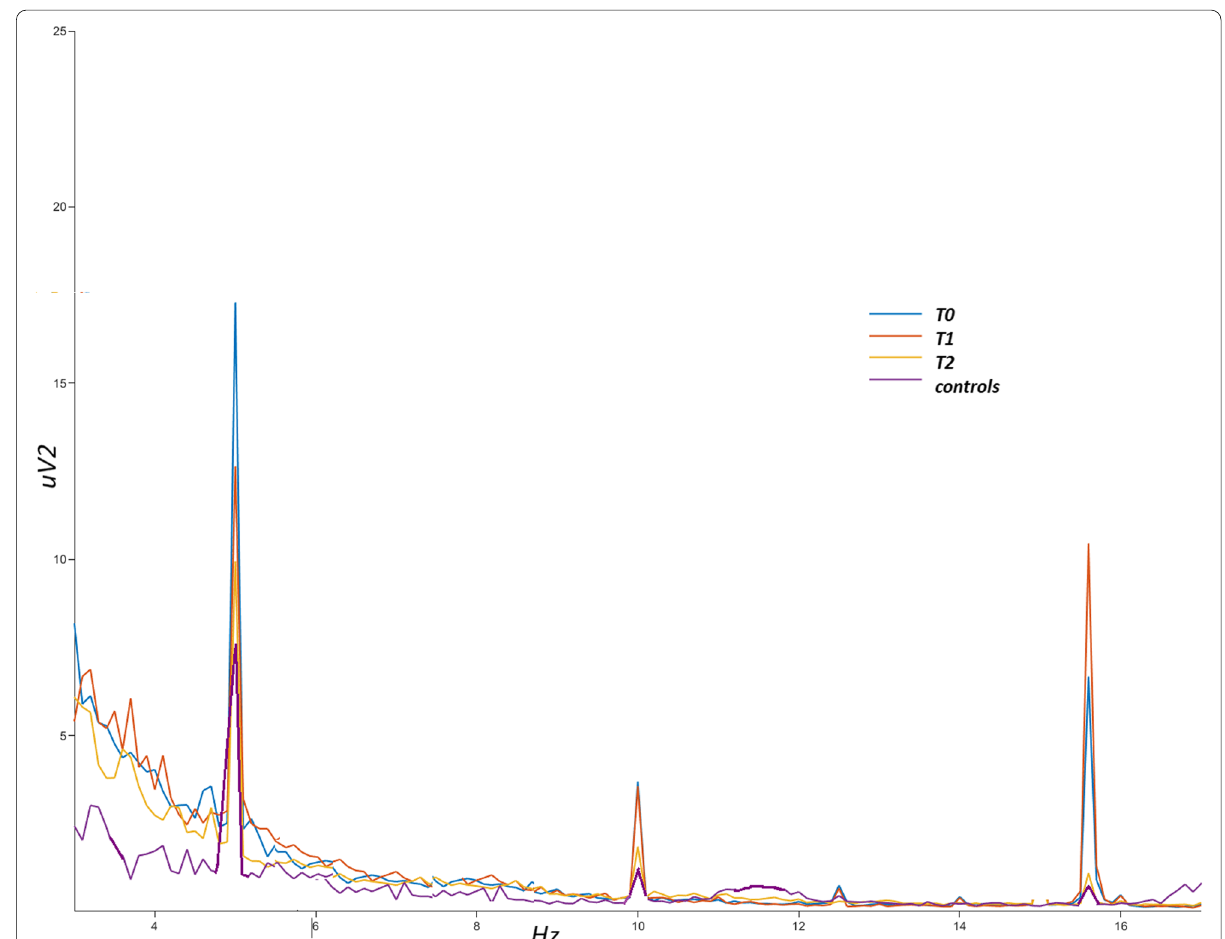
Fig. 4 Grand Average of Spectral components F (5 Hz), 2F (10 Hz) and 3F (15 Hz) over the channels Oz, O1 and O2 in controls and migraine patients at T0, T1, and